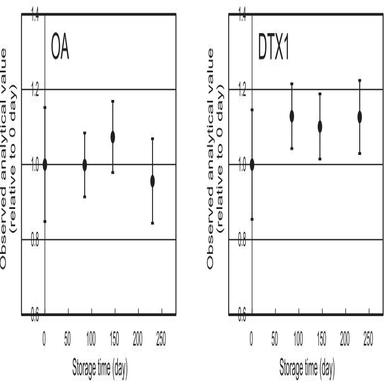
Trend of observed analytical values (relative) of OA and DTX1 during the long-term stability assessment of CRM 7520-a. The assessment was performed at −30 °C to −20 °C over 8 months. Each bar shows combined standard uncertainty calculated from the standard uncertainties associated with the deviation of the analytical results (n = 3) and the repeatability of LC–MS/MS measurements.